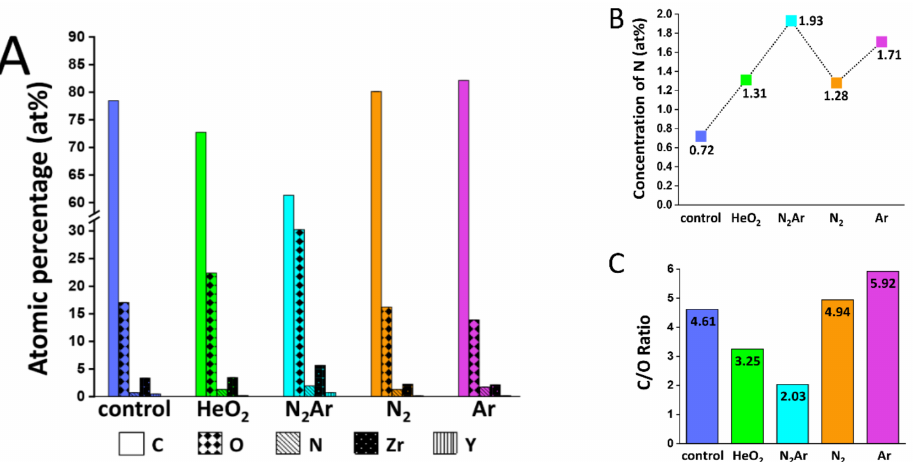
Figure 3. ( A ) Atomic percentage (at%) for each element detected in each plasma group; ( B ) Concen- tration of N in each plasma group; and ( C ) Carbon/oxygen ratio in each plasma